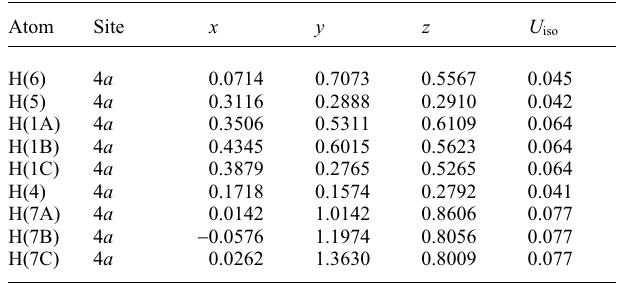
Table 2. Atomic coordinates and displacement parameters (in Å 2 ) . Table 1. Data collection and